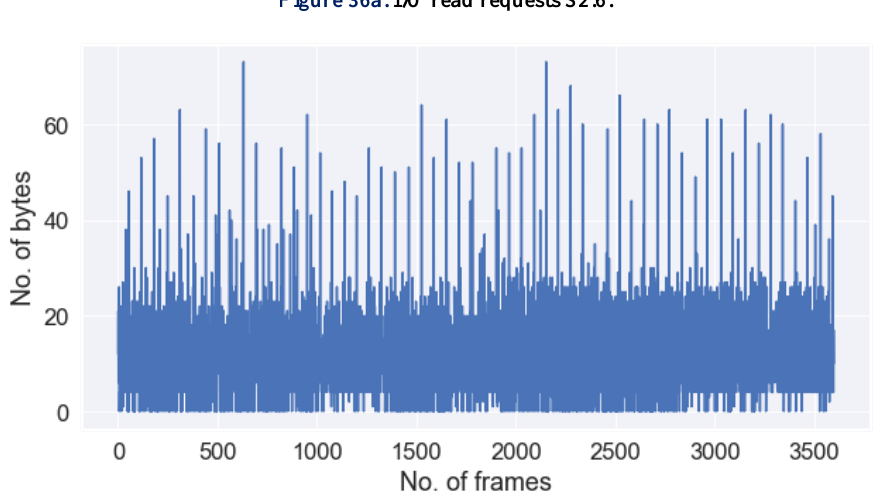
Figure 36b. I/O write requests